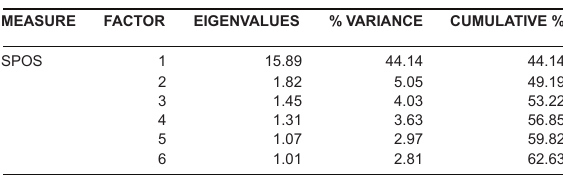
Table 1 Variance associated with the initial factors (N =